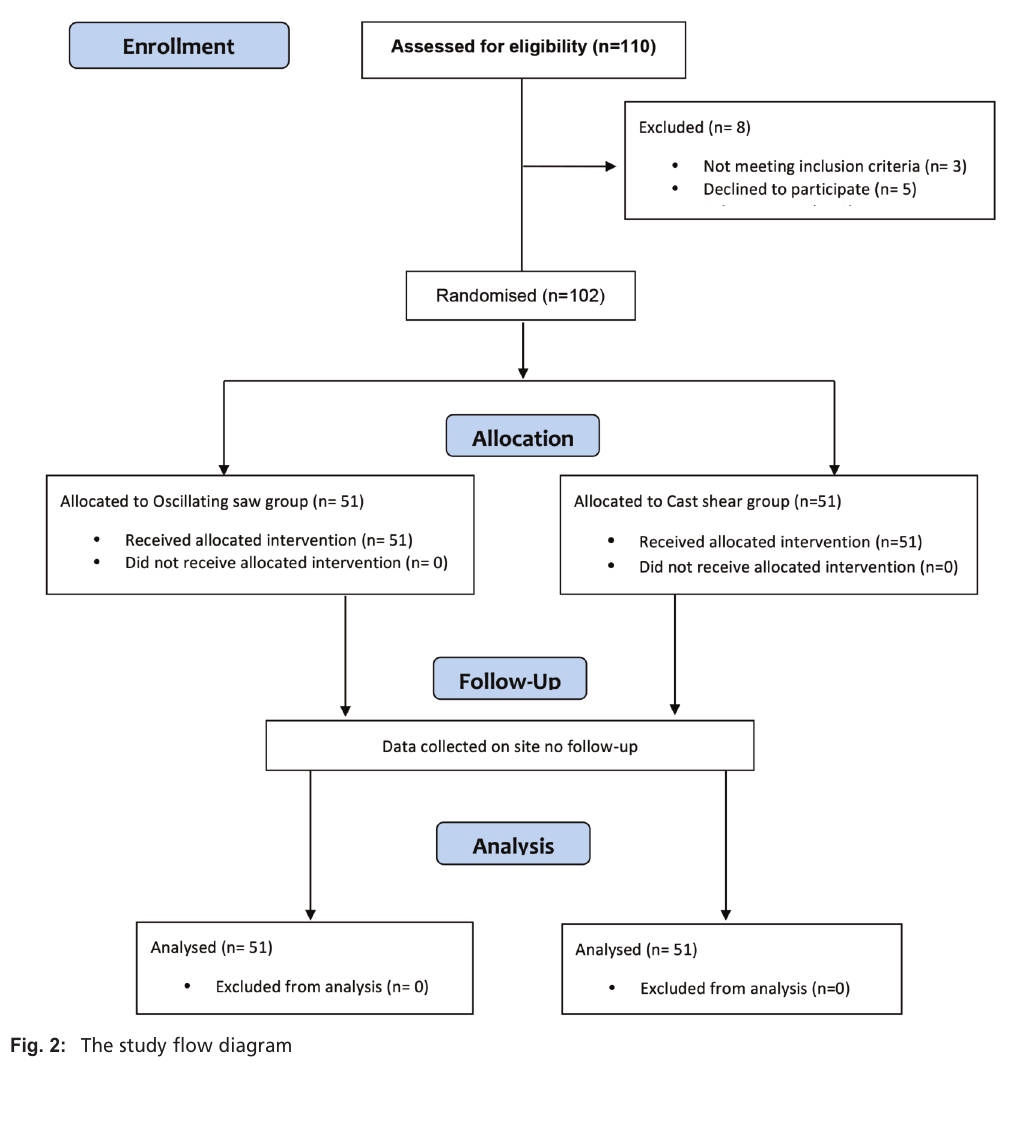
The study flow diagram Fig. 2: